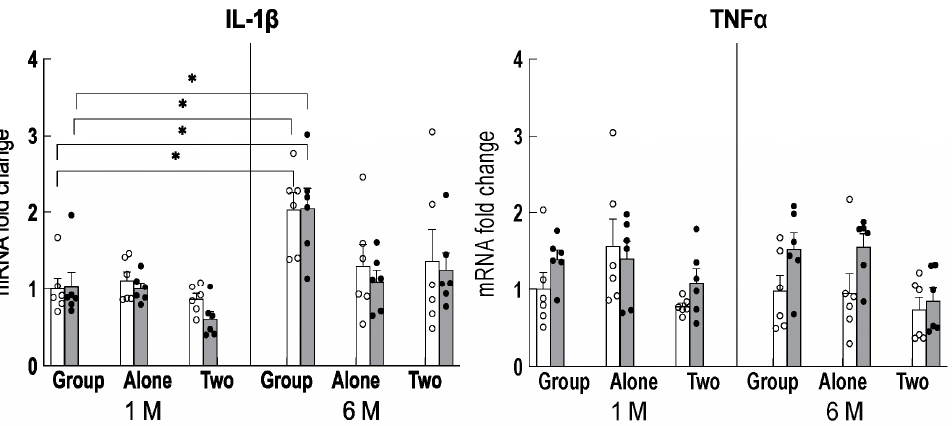
Figure 3. The expression of REST in the hippocampus and cerebral cortex under each rearing con- dition for 1 month (1 M, 2 months old) and 6 months (6 M, 7 months old) in control mice (open column) and theanine-ingesting mice (closed column). Each column bar represents the mean ± SEM (n = 6) overlaid on scatter plots (* p < 0.05, Tukey’s honestly significant difference method).